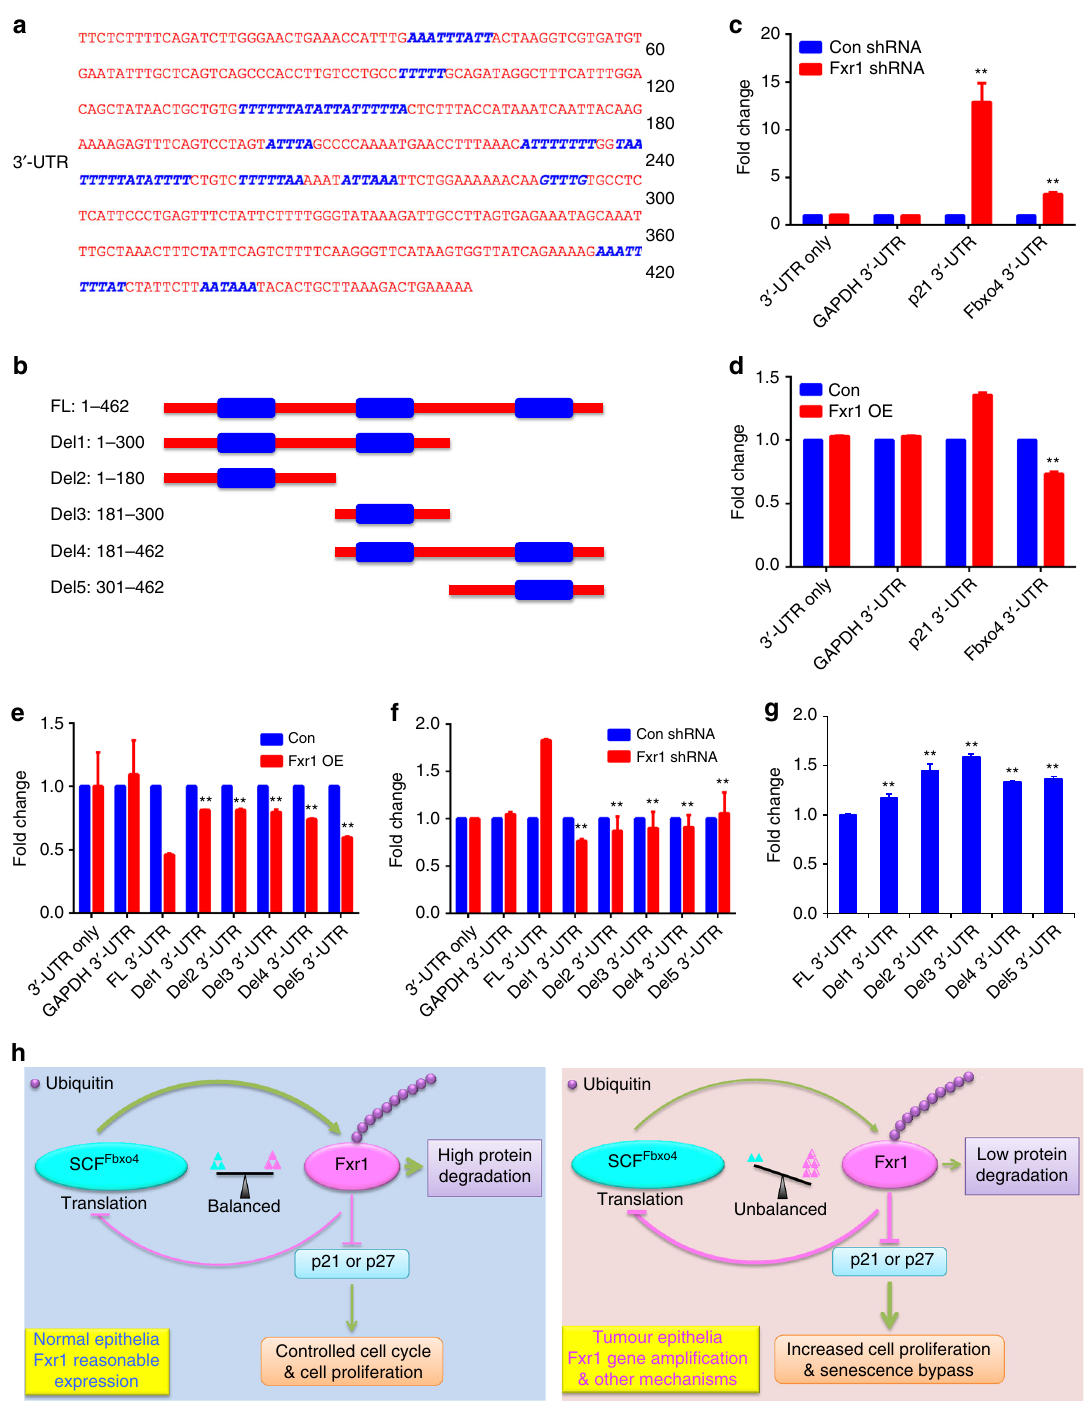
Fig. 7 Identi fi cation of the AREs that control Fbxo4 translation by Fxr1. a Schematic illustration of AREs in 3 ′ -UTR of Fbxo4 mRNA; AREs are indicated in blue. ARE prediction is performed using AREsite2: http://rna.tbi.univie.ac.at/AREsite2/welcome. b Deletions made based on the ARE distribution. FL: full- length; Del: Deletion. c Fxr1 knockdown promotes the luciferase activity-mediated by both 3 ′ -UTRs of p21 and Fbxo4 mRNAs in 74B cells. d Fxr1 overexpression suppresses the luciferase activity-mediated by 3 ′ -UTR of Fbxo4 mRNA in HEK293T cells. e ARE deletion rescues luciferase activity in HEK293T cells with Fxr1 overexpression. f ARE deletion reduces luciferase activity in 74B cells with Fxr1 knockdown. g The comparison of basal luciferase activity with full-length and deleting 3 ′ -UTRs of Fbxo4 mRNA in 74B cells. h Proposed model summarises the regulation of Fxr1 by Fbxo4 and feedback regulation of Fbxo4 by Fxr1. All the data represent mean ± s.d. c , d were analysed by Student ’ s t test ( n = 3). e – g were analysed by One-way ANOVA, followed by Fisher ’ s LSD as post hoc test ( n = 3). ** p <